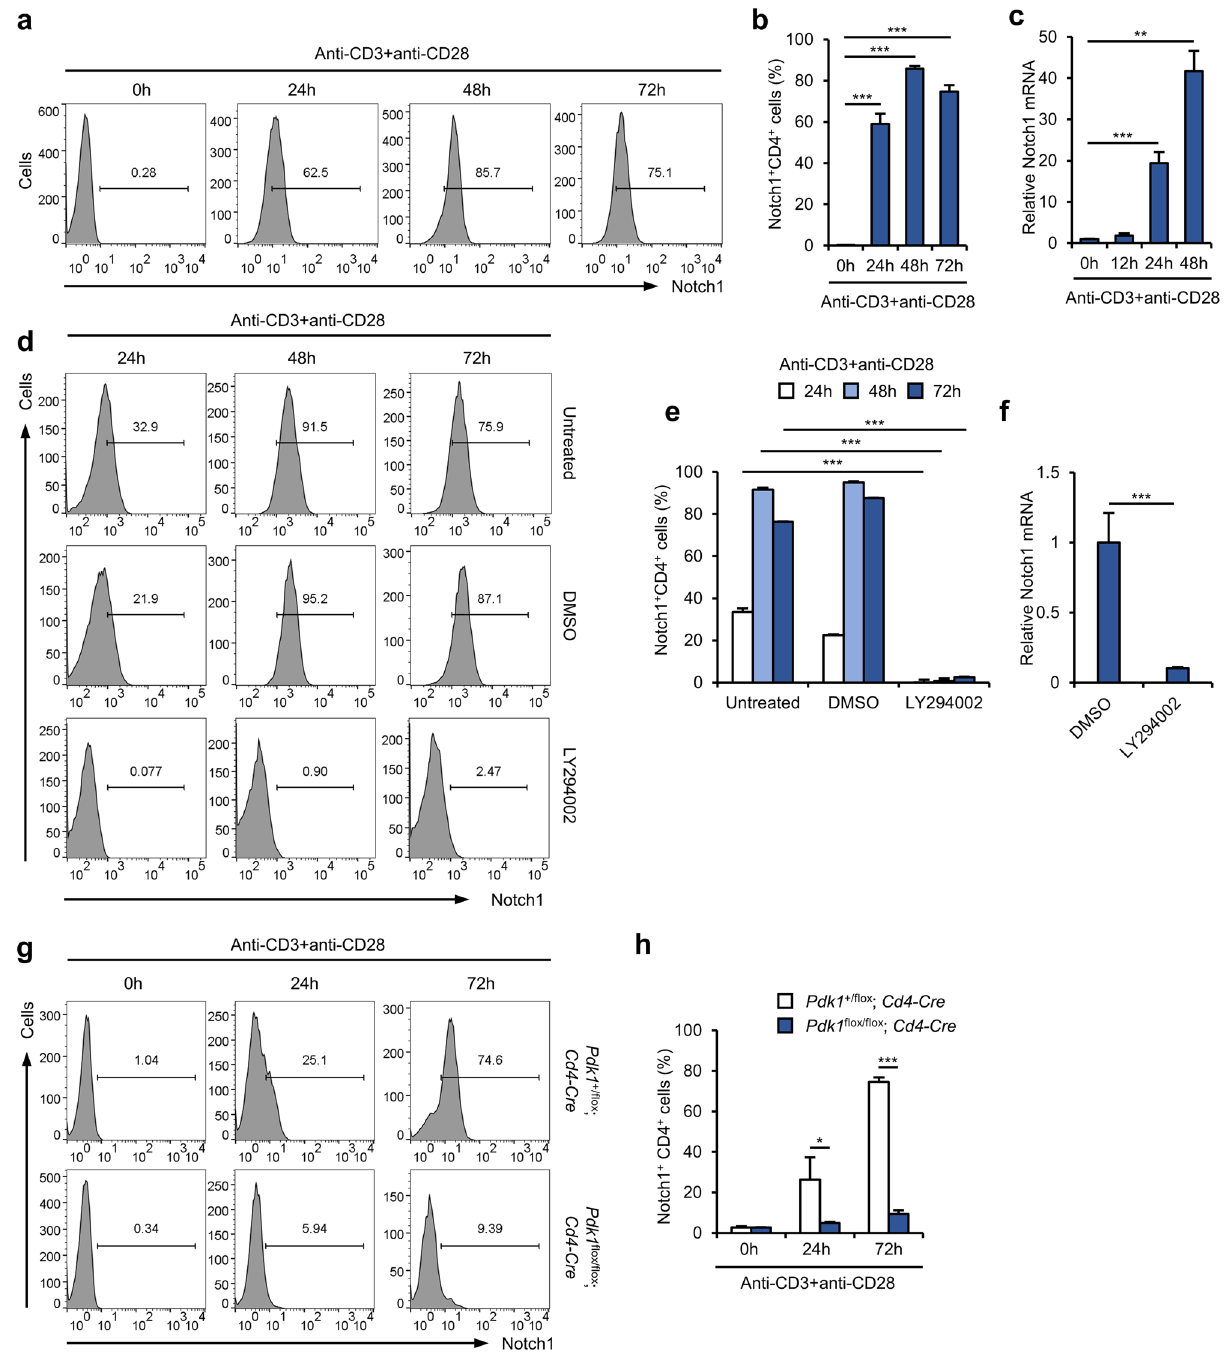
Figure 1. Notch1 expression is upregulated in activated primary CD4 + T cells via the PI3K-PDK1 pathway. ( a, b ) Flow cytometry for surface Notch1 expression after cellular activation using anti-CD3 and anti-CD28 antibodies for the indicated times. ( c ) Quantitative real-time PCR for Notch1 mRNA expression after cellular activation. ( d, e ) Flow cytometry for surface Notch1 expression after treatment with the PI3K inhibitor LY294002. ( f ) Quantitative real-time PCR to detect Notch1 mRNA after cells were activated by anti-CD3 and anti-CD28 antibodies for 48 h in the presence of LY294002. ( g, h ) Flow cytometry for surface Notch1 expression in PDK1-deficient CD4 + T cells. Data are mean ± SD. * P ≤ 0.05, ** P ≤ 0.01, and *** P ≤ 0.001 (Student’s t